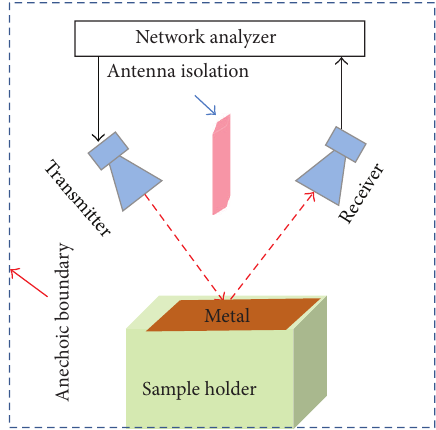
Figure 7: Schematics of the setup for the measurement of reflection coefficient of metal plate using the S21 parameter.